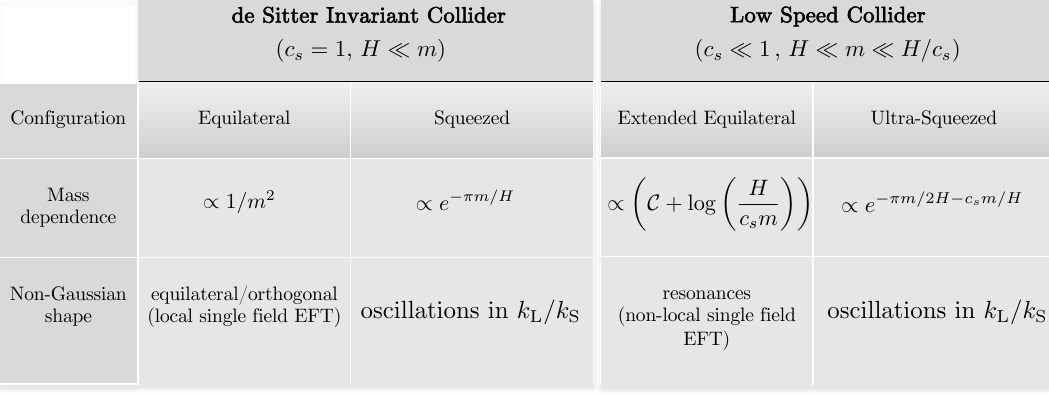
= 1 ) and low speed s is set to unity by rescaling the spatial coordinates. σ . k 6 1 , with the quoted m s L /k S H